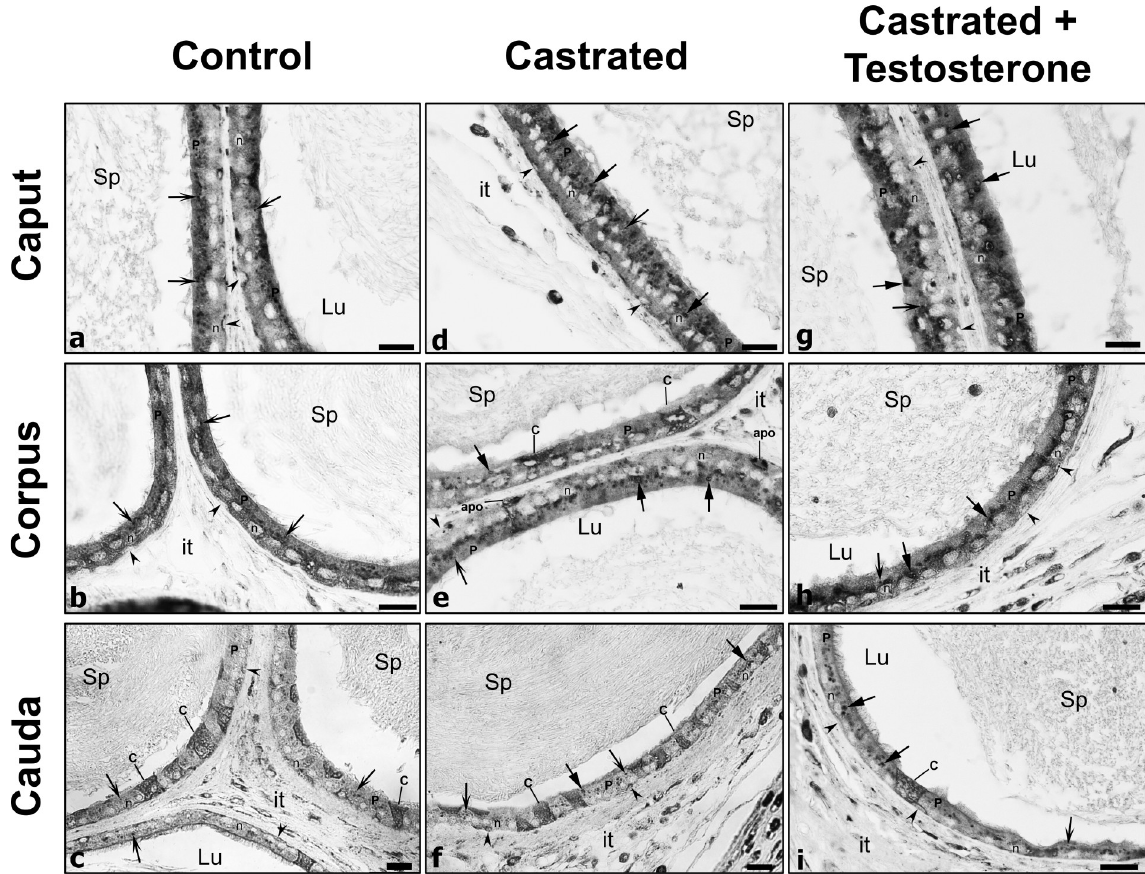
Fig 5. Low power of epididymal tubules of caput, corpus and cauda regions from control (Con), castrated (Ct) and castrated with testosterone supplementation (Ct+T) animals immunostained with prosaposin. While small reactive spherical lysosomes (winged arrows) appear in principal cells (P) of all 3 groups, in (Ct) animals, lysosomes (triangular head) appear to be larger in size and more abundant, with some remaining large in (Ct+T) animals. Some of these lysosomes show a dense homogeneous appearance, while others show a densely stained ring enveloped by a pale central core (triangular arrows). Apo, apoptotic basal cell; Lu, lumen; it, interstitial space; Sp, spermatozoa; reactive basal (arrowheads) and clear (C) cells; n, nuclei of principal cells. Scale bars = 20 μ m.